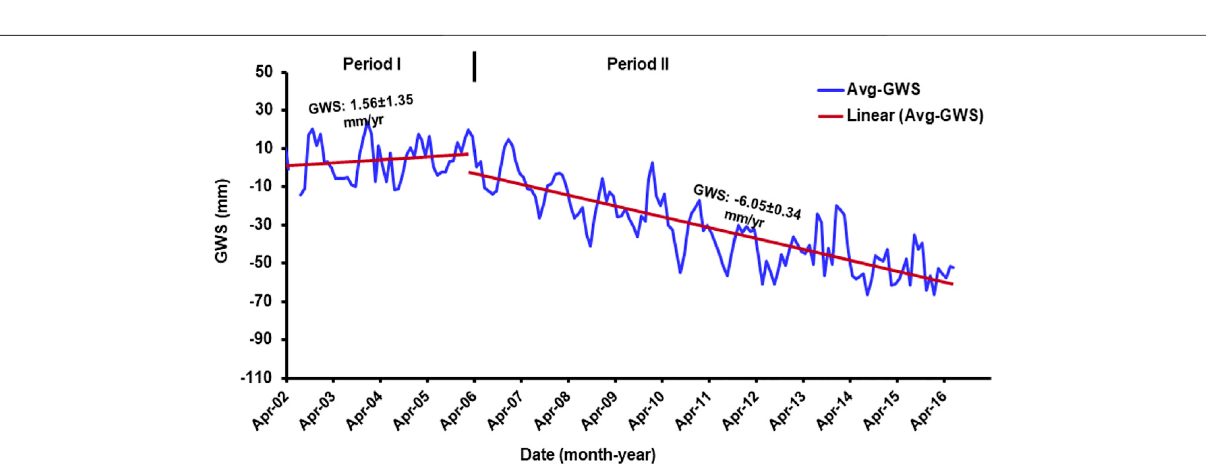
Frontiers in Earth Science |